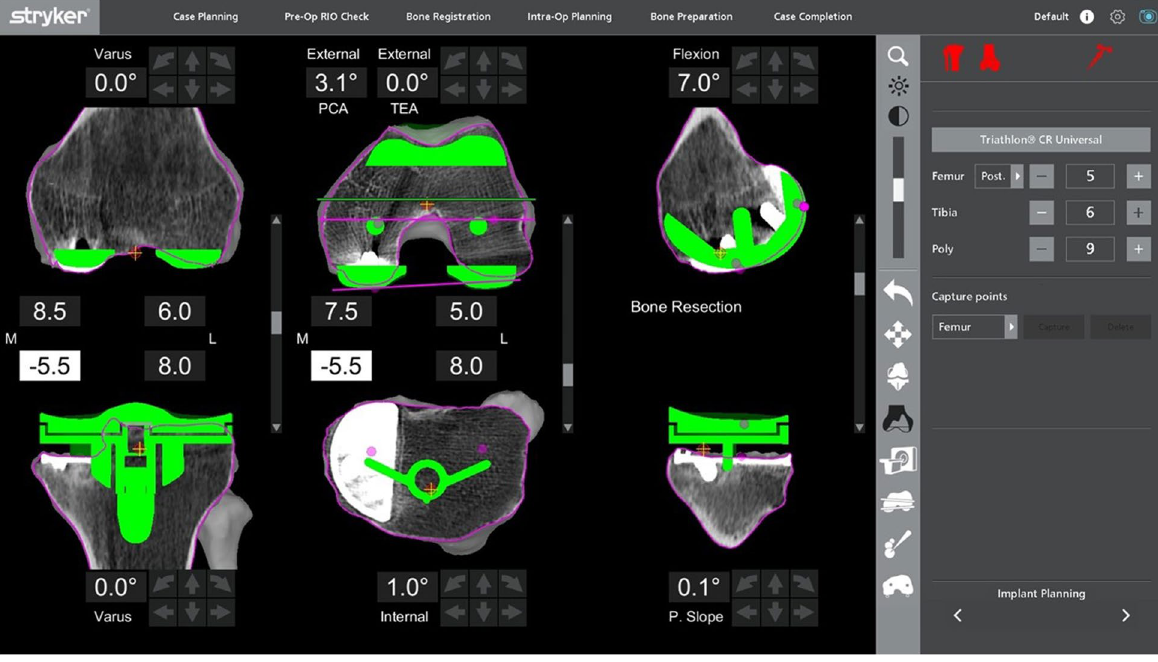
Fig. 10 Alternative mechanically‑aligned knee plan for the patient in Fig. 9